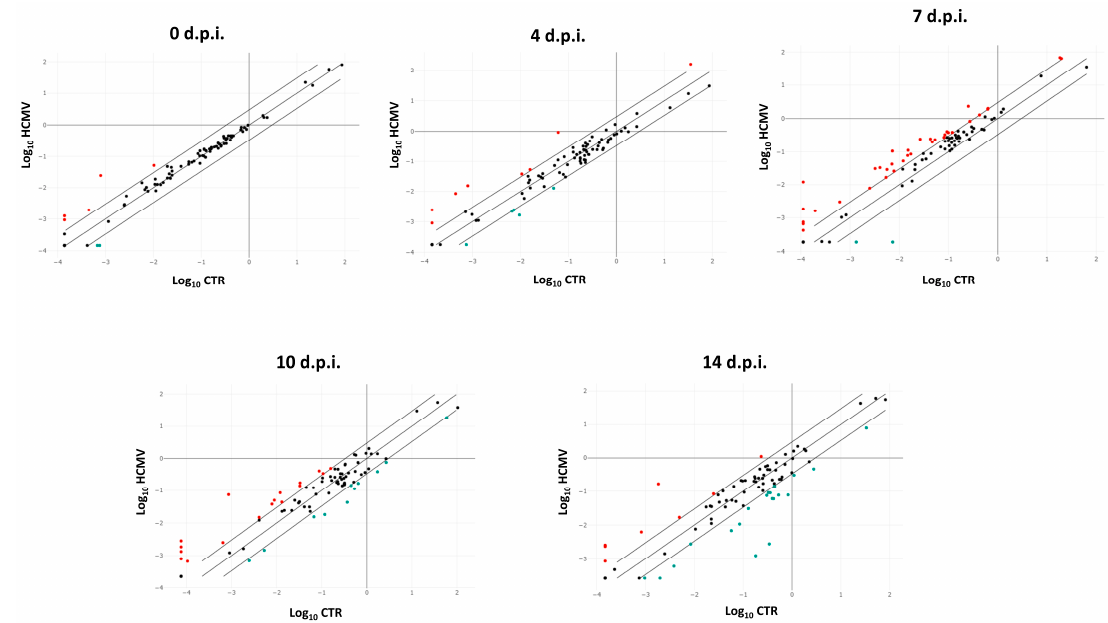
Figure 5. Scatterplot representation of the apoptosis-associated factors altered by human cytomegalovirus (HCMV) infection in primary human dermal fibroblasts. At each time p.i. (d.p.i. = days post-infection), cell samples were collected and analyzed by specific qPCR microarray. The significance threshold was put at 3-fold expression change in infected vs. uninfected control cells. Red dots: upregulated factors; blue dots: downregulated factors; black dots: not significantly altered factors. Results represent mean values of duplicate samples from two independent experiments, and are expressed in logarithmic scale (Log 10 HCMV = logarithmic values in HCMV infected cells; Log 10 CTR = logarithmic values in control uninfected